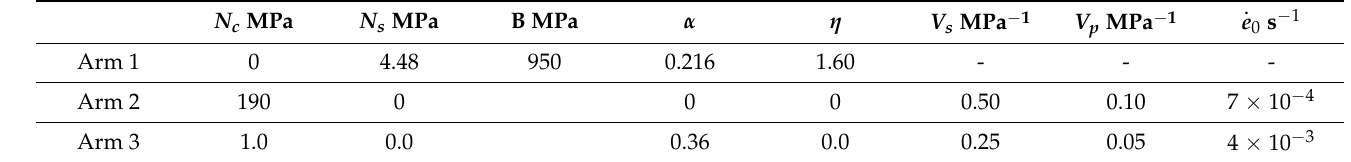
Table 1. Three-arm model